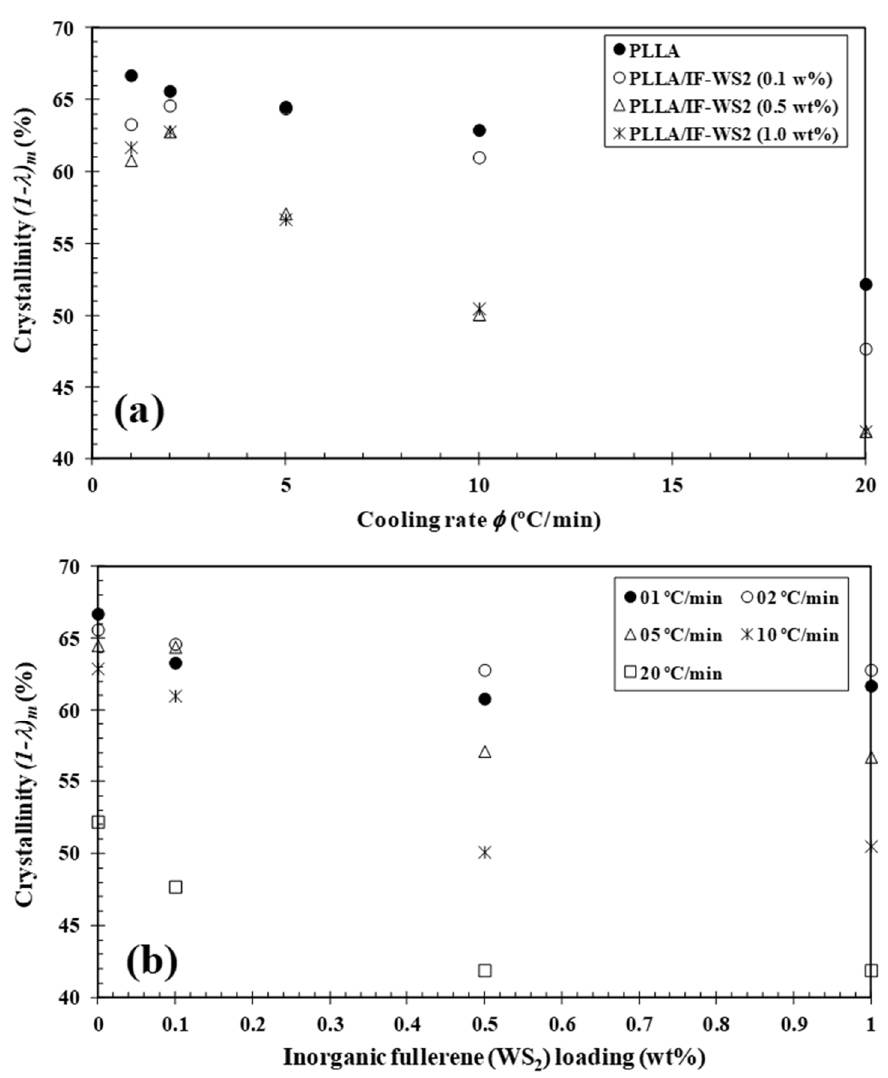
Figure 5. Variation in the melting crystallinity (1 − λ ) m of PLLA/IF-WS 2 nanocomposites with ( a ) cooling rate and ( b ) IF-WS 2 concentration.